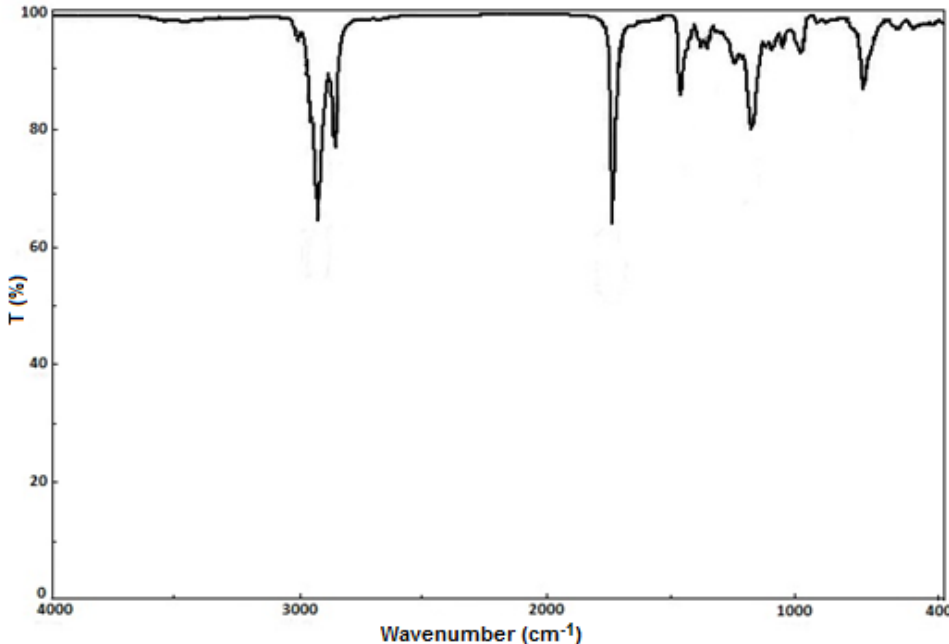
Figure 6. FT-IR analysis of the bioester B3.